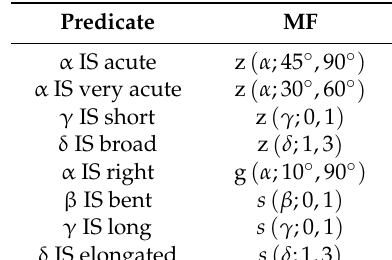
Table 3. Membership function (MF) parameter settings for testing. z( α ; a, b) is asymmetrical polynomial curves open to the left where α is the junction angle and a and b locate the extremes of the sloped portion of the curve; s( α ; a, b) is opposite curve to Z curve; and g( α ; σ , m) is a Gaussian distribution curve where m is the center and σ controls the width of the curve.